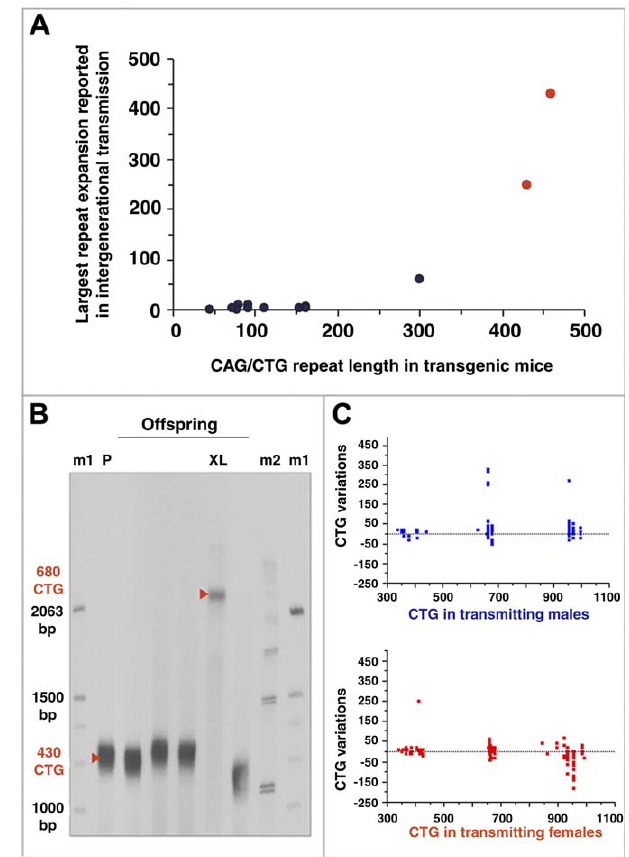
Figure 1. Big Jumps in Mice: Striking Intergenerational Trinucleotide Repeat Instability in Transgenic Mice (A) Transgenic mouse models of CAG (cid:2) CTG instability previously generated exhibited modest intergenerational repeat expansions (blue dots). The largest expansions reported were smaller than 10 CAG (cid:2) CTG repeats, with the exception of the DM300–328 line, in which inter- generational repeat gains reached þ 60 CTG [9]. Large CTG big jumps of several hundred repeats were recreated in a transgenic mouse model of DM1 carrying over 400 CTG repeats (red dots). To our knowledge, the repeat gains observed are the largest ever reported in transgenic models of unstable trinucleotide repeats. (B) Transmission of a very large expansion from a male parent (P) to its offspring. m1 and m2 indicate 100-bp and 250-bp molecular weight markers, respectively. (C) Intergenerational CTG size variation (yy axis) is represented for different CTG repeat lengths (xx axis) in male (top graph, blue dots) and female transmissions (bottom graph, red dots).